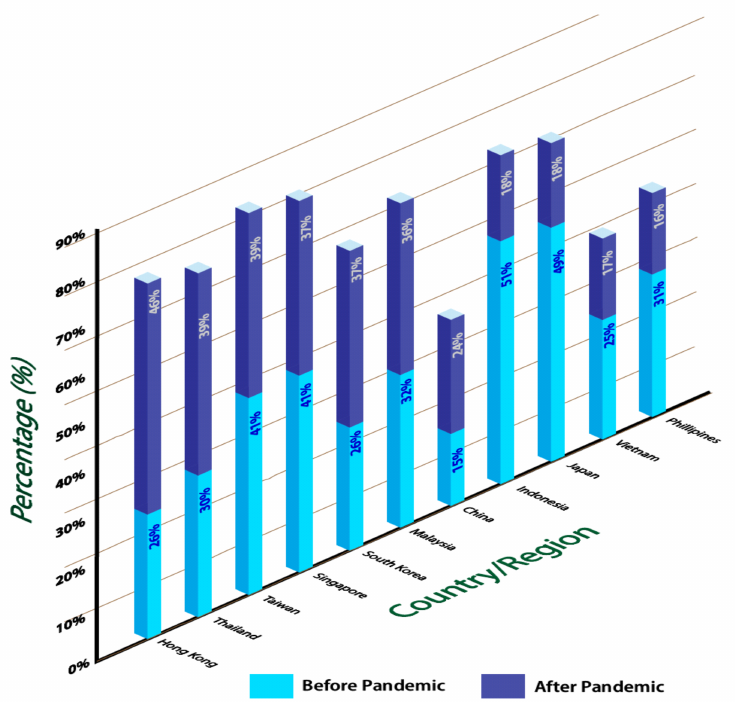
Figure 1. COVID-19’s impact on consumers ordering food, APAC 2020, by country or region. Modified from